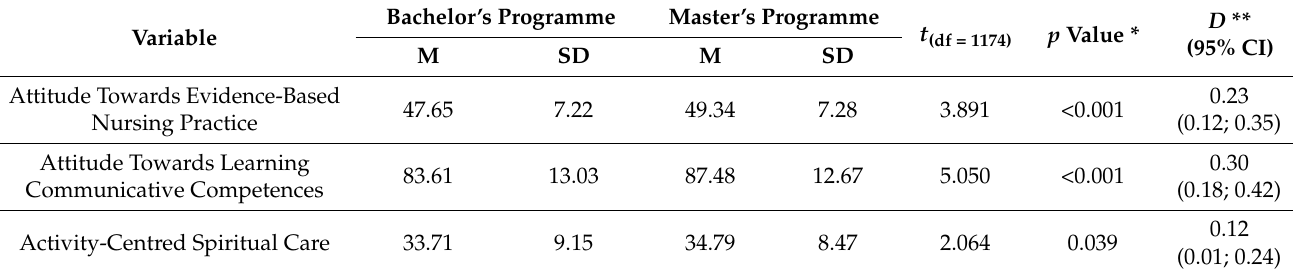
Table 2. Comparison of two study groups in terms of